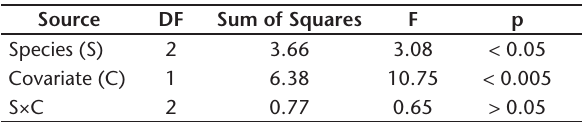
Table 2. ANCOVA results for species identity, the covariate and the interaction term on